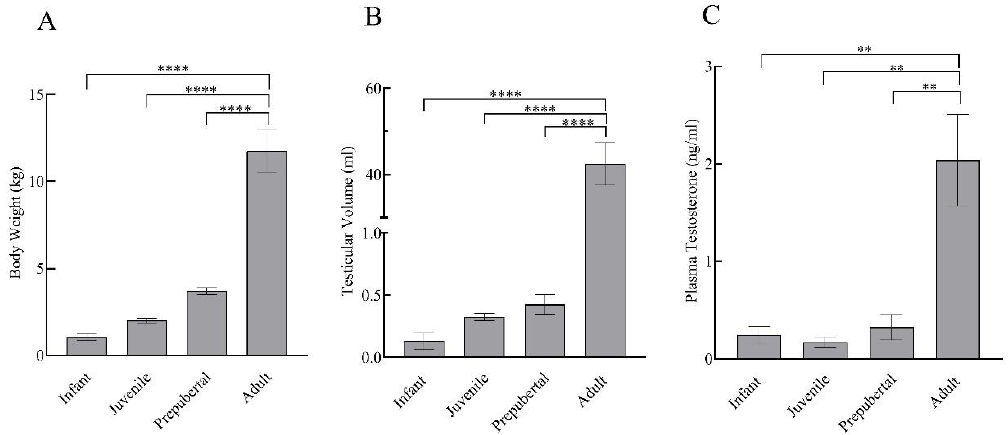
Figure 1. Body weight ( A ), testicular volume ( B ), and plasma testosterone levels ( C ) of infant ( n = 3), juvenile ( n = 4), prepubertal ( n = 4), and adult ( n = 4) male rhesus monkeys. All data are presented as the mean ± SEM. ** p < 0.01, **** p < 0.0001.